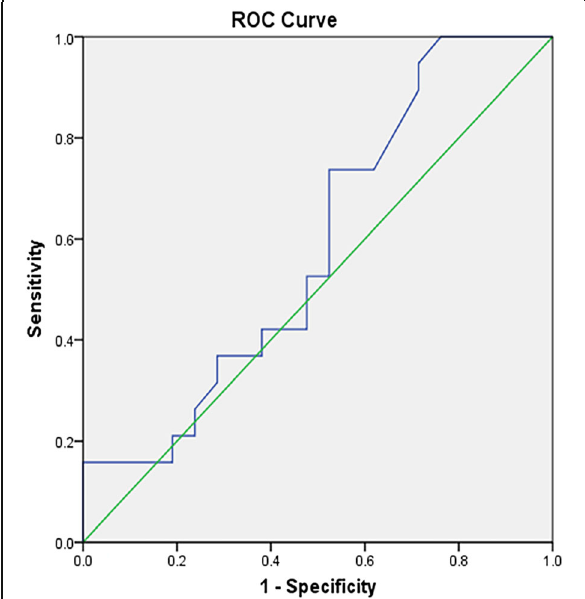
Fig. 1 ROC showing poor diagnostic performance of urinary LRG Fig. 2 ROC showing better diagnostic performance of